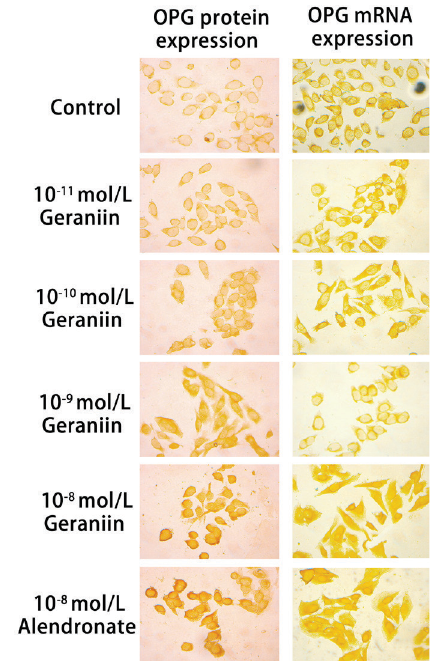
FIGURE 8 - Representative images of immunocytochemistry staining for OPG protein expression (A) and in situ hybridization staining for OPG mRNA expression(B). Geraniin (10 -11 -10 -8 mol/L) increased IOD and MOD values of OPG mRNA and protein expression in positive cells.